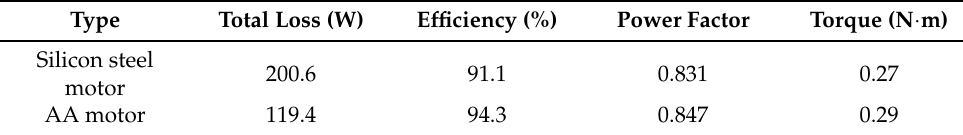
Table 4. Comparison of the Performance Parameters at Rated